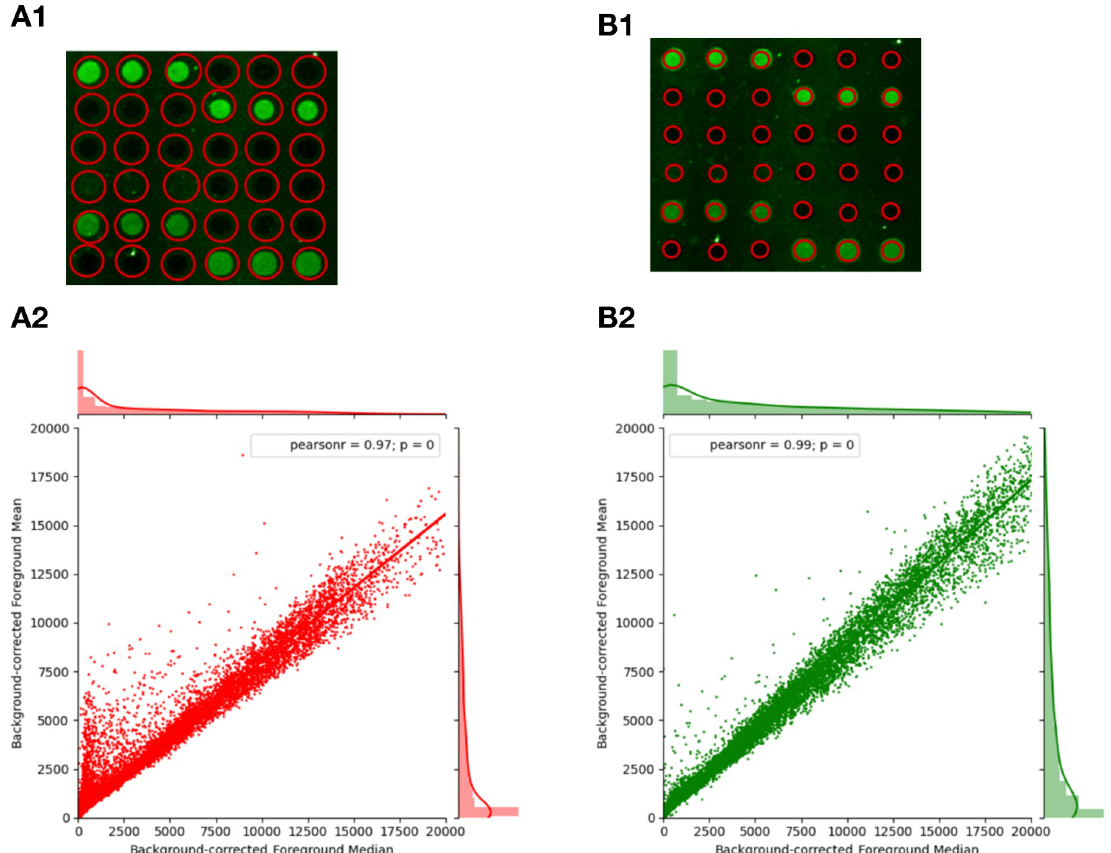
Fig 3. Detection of mislabelled pixels due to errors in spot alignment. A1. Scanning grid where spot size is too large. A2. Linear regression of foreground means (less background) on foreground medians (less background) of a typical suboptimal spot alignment where the estimated spot (feature) size is much larger than the feature’s actual size (shown A1), capturing much of the background area of the array. This leads to the indicative crest of points x < 5000 and a slope much lower than 1 (0.755). B1. More accurate spot size used for scanning. B2. Linear regression of background-corrected foreground means on background-corrected foreground medians of a spot alignment better optimized for kinome microarrays, manually selecting a much smaller diameter for each feature (shown B1). Improved alignment removes the crest feature in the regression plot and raises the slope to 0.855. Frequency histograms along the x- and y-axes show the overall distribution of the background-corrected median and the background-corrected median, respectively. In A1 and B1 actual spots are shown in green, and the boundary of the area labelled as foreground pixels is shown in red. Data is taken from the TLR4 experiment described